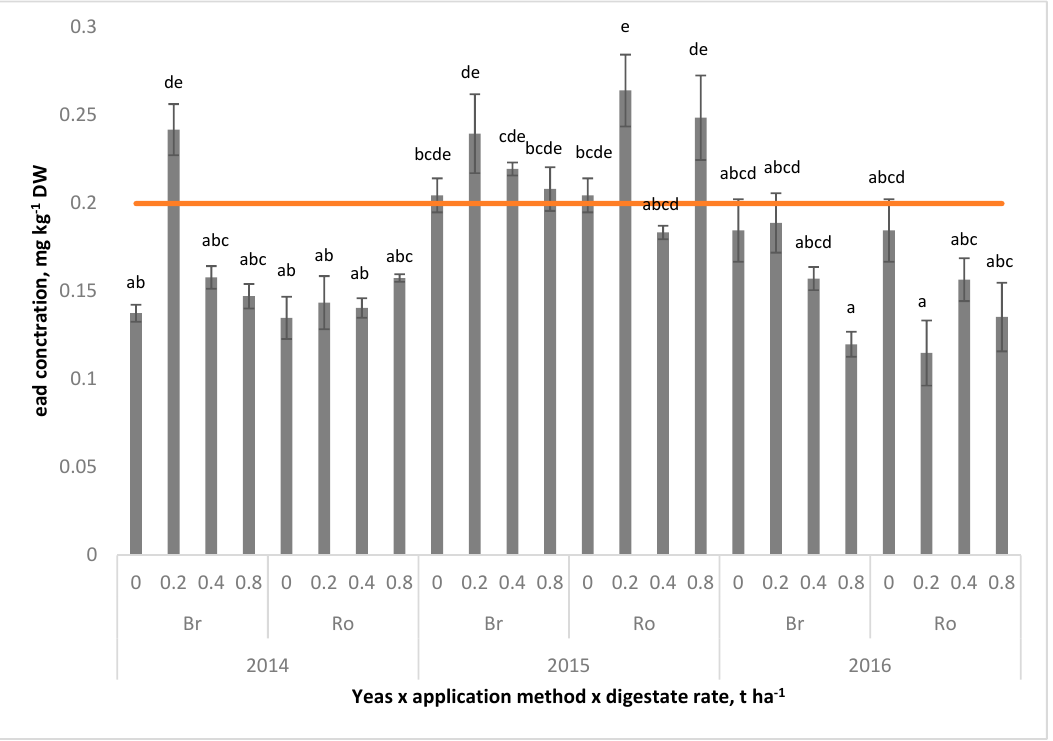
Figure 6. Effect of the method and rate of digestate on the lead concentration in maize grain in consecutive years on the background of the threshold Pb concentration. a Numbers marked with the same letter are not significantly different; the bars indicate a double standard error of the mean ( n = 4).